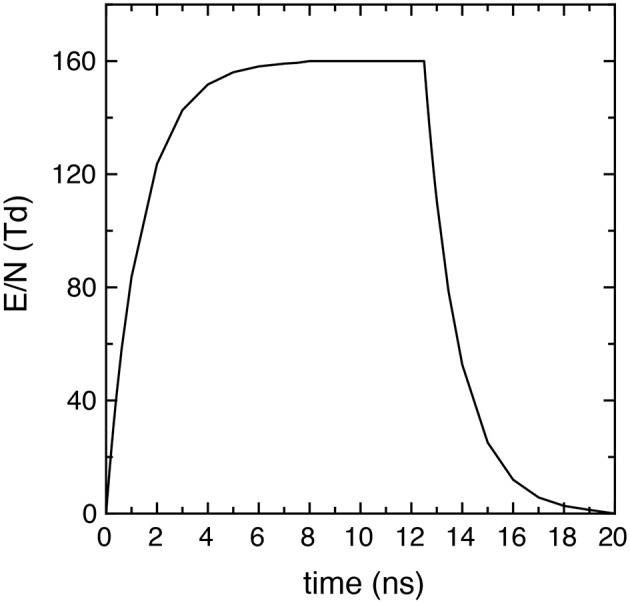
Reduced electric field time profile in each pulse used in all the simulations (EM/N = 160 Td, tr = tf = 7.5 ns, τr = τf = 1.35 ns and tp = 20 ns).